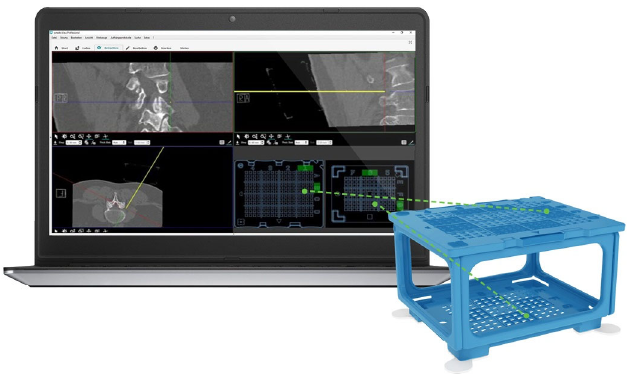
Figure 1. The CNS system consisting of the PC on the right, and software on the left. The software displays the standard MPR views in coronal, sagittal and axial views. Shown here is an example infiltration at the lumbar level. The chosen trajectory of the virtual needle is shown as a highlighted yellow cross-hair marker which can be freely moved. Based on the trajectory of the needle, the corresponding coordinates in the upper-left and lower-right templates are highlighted by the software. The physical puncture needle is then inserted through these holes.